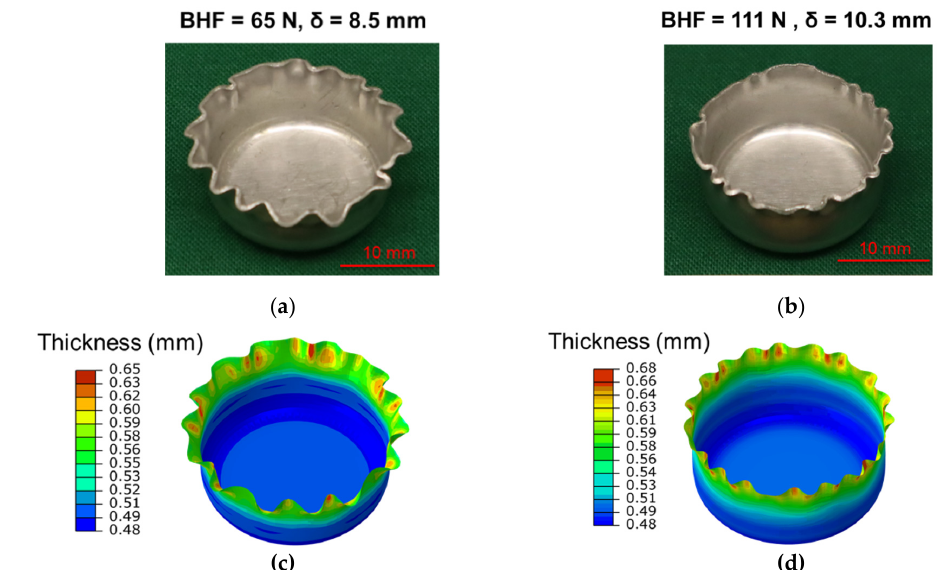
Figure 13 . Comparison of the wrinkled cups from simulations and experiments at certain draw depth: ( a , c ) 65 N BHF case at draw depth of 8.5 mm; ( b , d ) 111 N BHF case at draw depth of 10.3 mm. Superimposed contours represent the thickness.